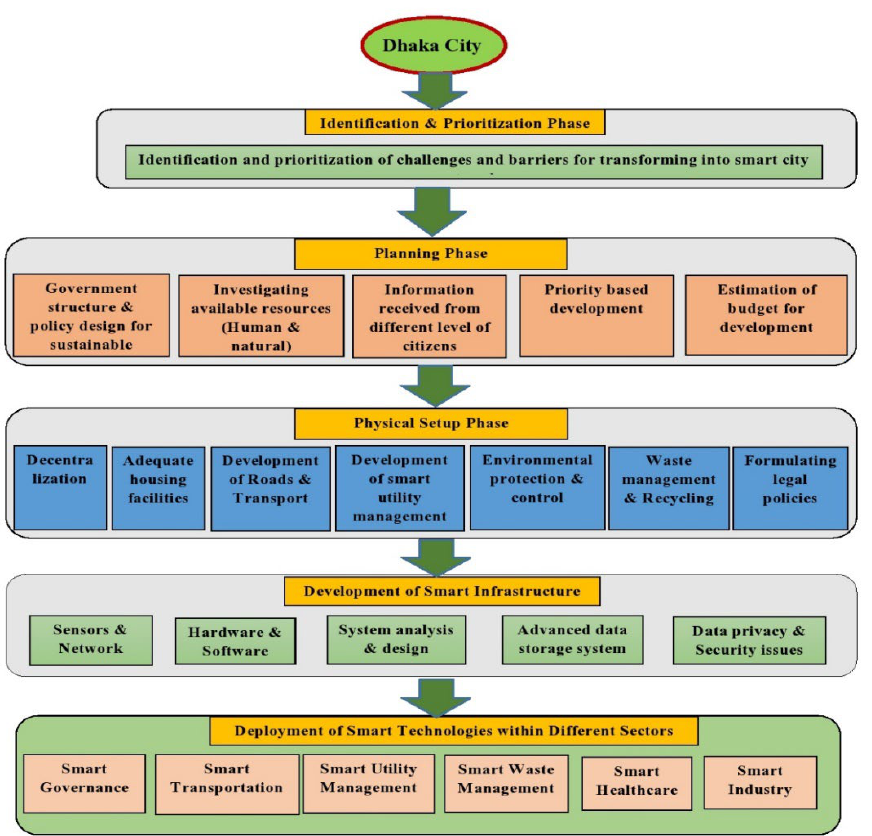
Figure 8. Smart city transformation framework for Dhaka.